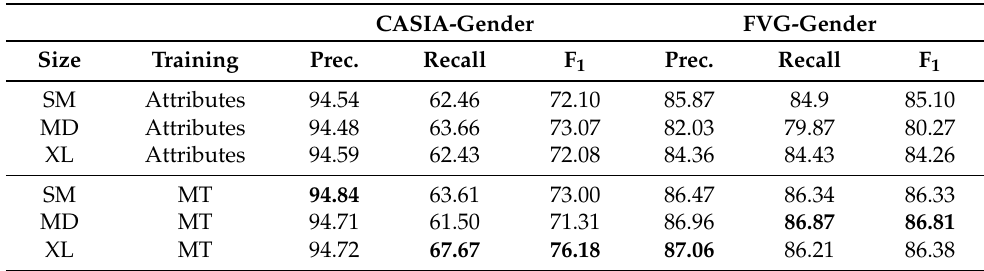
Table 6. GaitFormer direct transfer performance on gait-based gender estimation on CASIA-gender and FVG-gender. We highlight in bold the best overall results for each